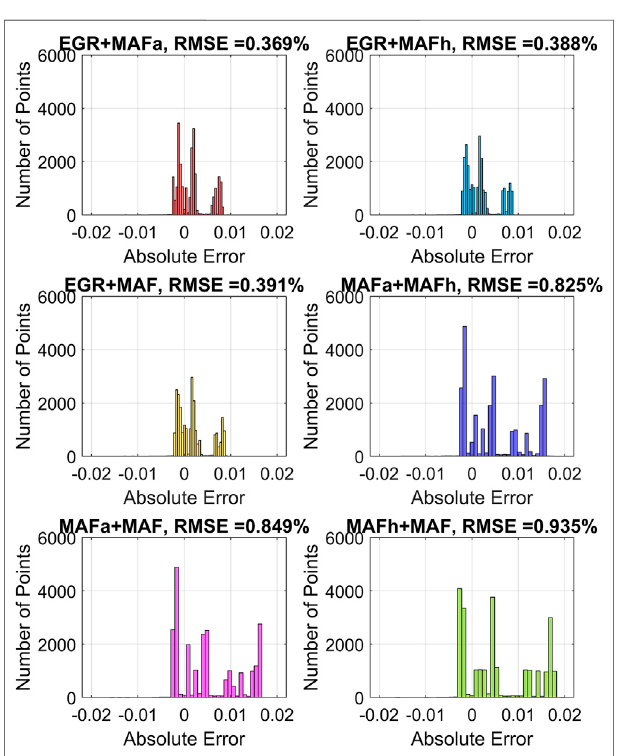
FIGURE 13 | Histograms of intake manifold burnt gas mass fraction estimation error when using two sensors.